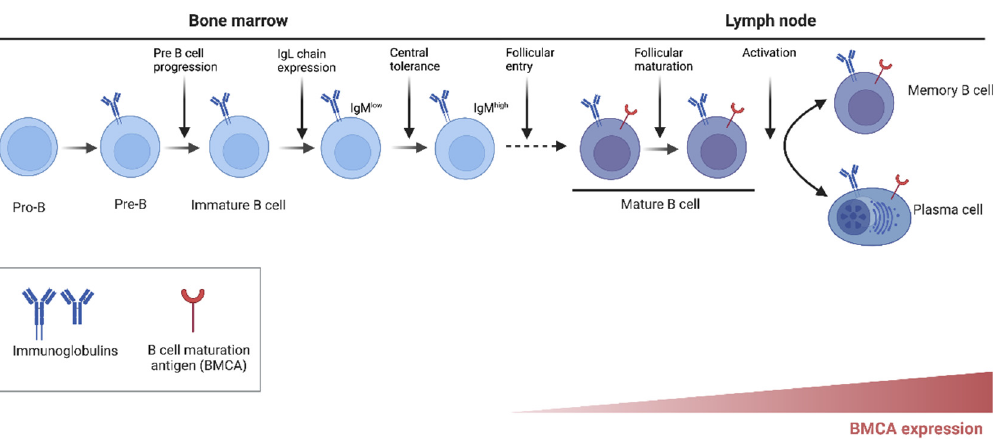
Figure 1. Role of BTK in B-cell development and activation from Pro-B cells (first expression of BTK) to fully differentiated memory B cells or plasma cells. The key steps including progression to pre-B cells, expression of immunoglobulin chains, follicular maturation, and differentiation into memory and plasma cells are indicated by vertical arrows [21].